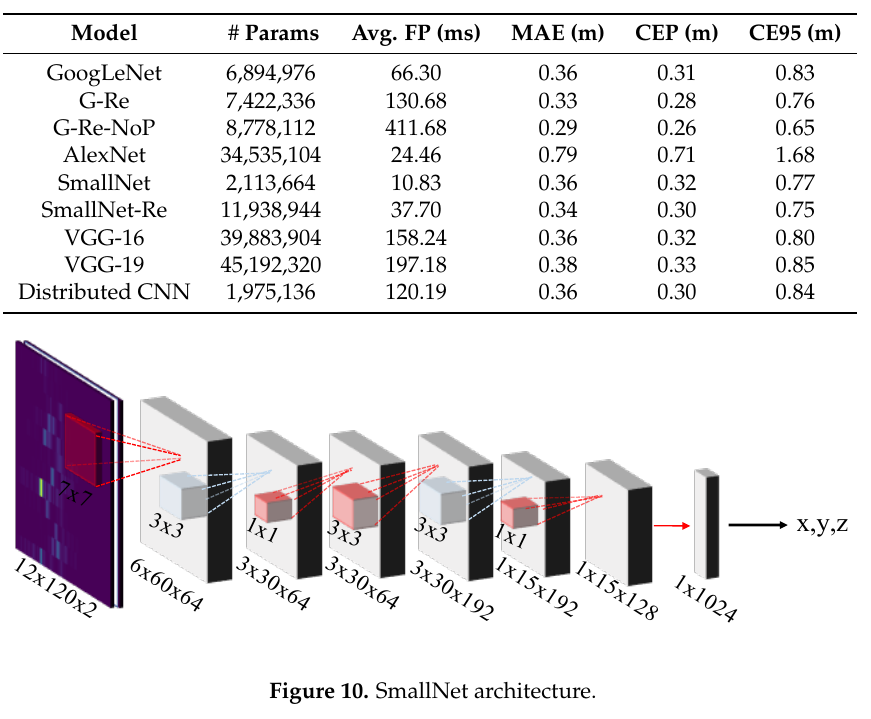
Table 3. Results and parameters of different architectures [1].